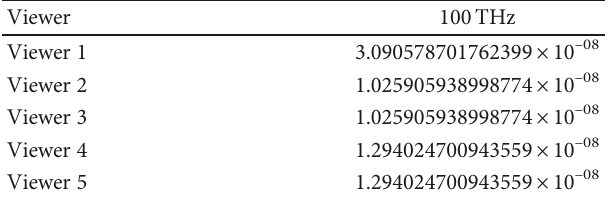
Table 4: Mean squared error ( E z ) for each viewer on the CNWG, between the reference and the CPML experiments, for a propagation frequency of